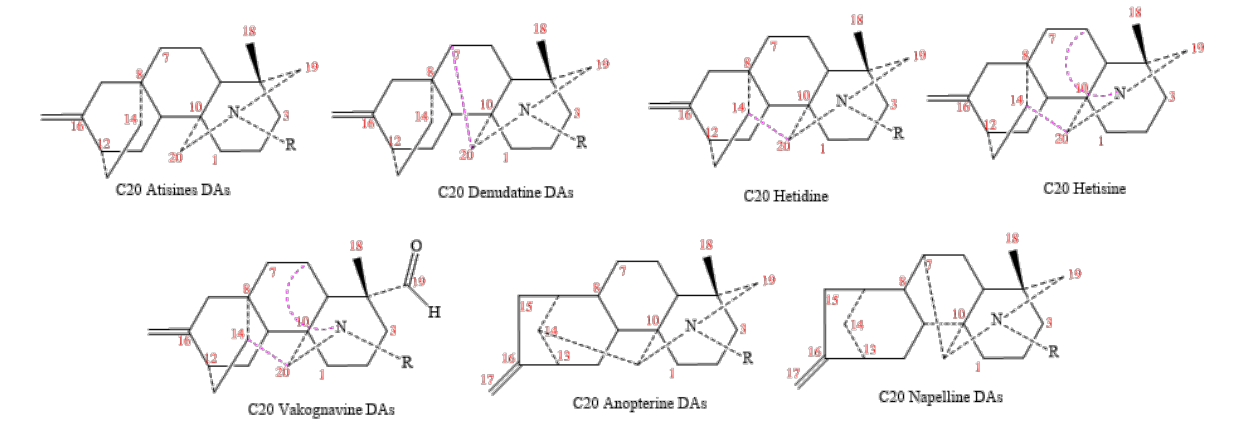
Figure 12. DAs-C 20 classes.